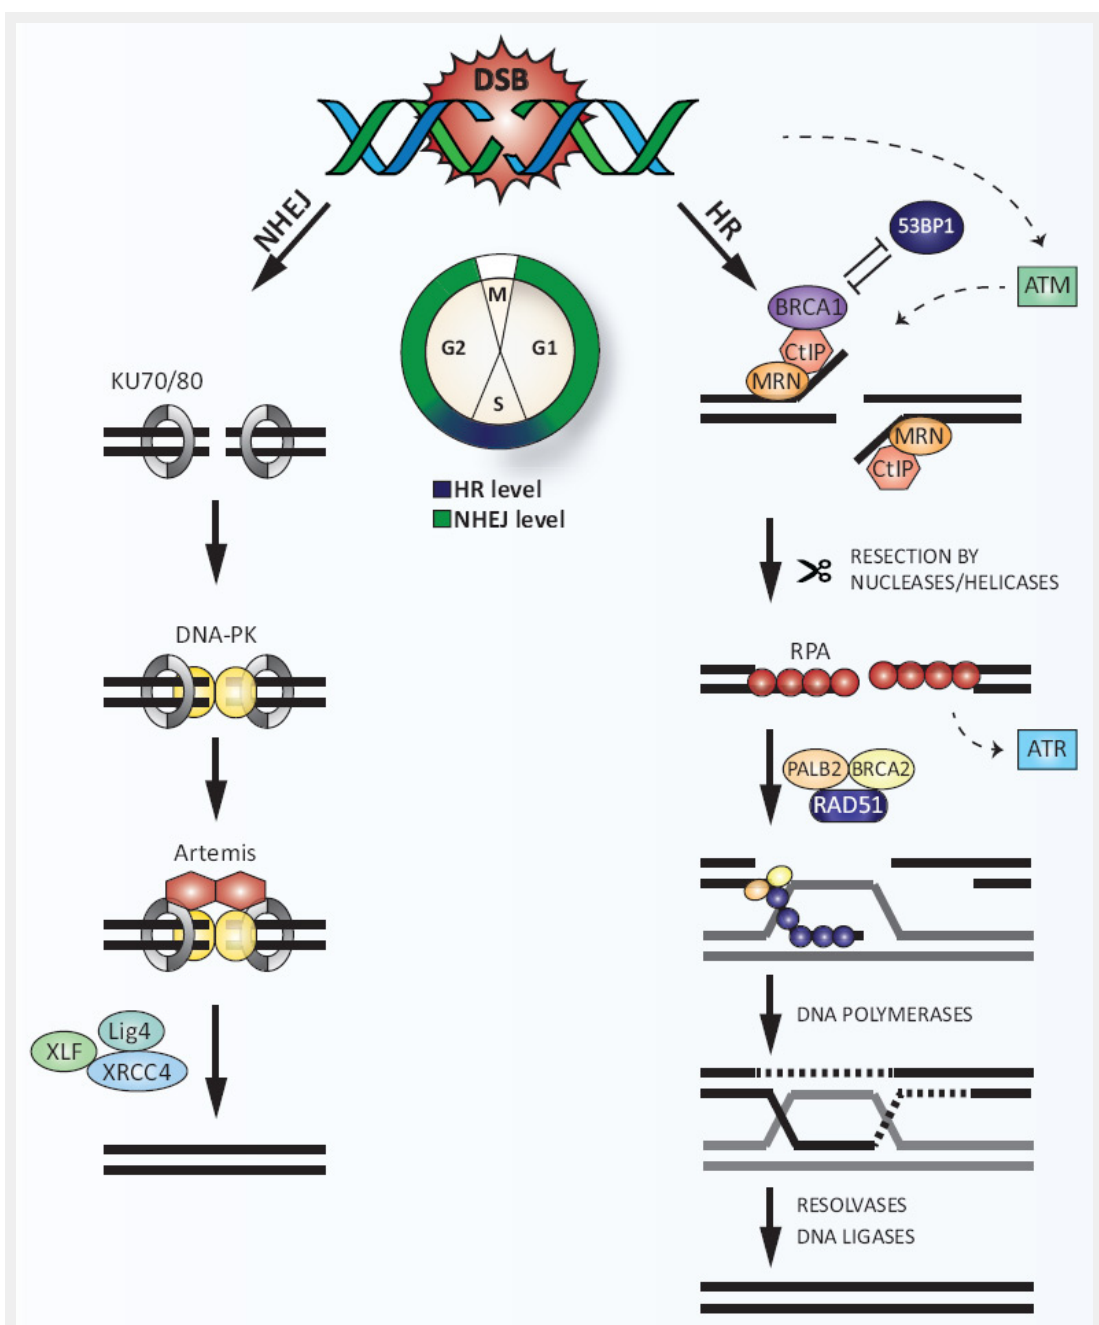
DNA double-strand break (DSB) repair. DSBs are predominantly repaired by two distinct pathways: NHEJ or HR. NHEJ operates throughout the cell cycle, but mainly during the G1 and G2 phases, whereas HR peaks in S phase. Rapid association of the Ku70/80 heterodimer to DSBs promotes NHEJ by recruiting DNA-PKcs. DNA ends are processed by the nucleolytic activity of Artemis, followed by religation catalysed by a complex of XLF, Ligase IV (Lig4) and XRCC4. Alternatively, MRN, which is initially recruited to DSBs in competition with Ku70/80, initiates DSB resection together with CtIP thereby promoting HR. 53BP1 antagonises BRCA1 in DSB resection. Extensive DSB resection by other nucleases and formation of RPA-coated ssDNA stimulates the activation of ATR. Displacement of RPA by RAD51 is mediated by BRCA2 and PALB2, resulting in the formation of RAD51 nucleoprotein filaments. Subsequent strand invasion into the homologous DNA template and capturing of the second DNA end leads to the formation of a double Holliday junction, which is processed by resolvases. Finally, the DNA is sealed by ligases to accomplish error-free repair of the DSB. 53BP = p53 binding protein; ATM = ataxia telangiectasia mutated protein; CtBP = C-terminal binding protein; CtIP = CtBP-interacting protein; DNA = deoxyribonucleic acid; DNA-PK = DNA-dependant protein kinase; DNA-PKcs = DNA-PK catalytic subunit; HR = homologous recombination; MRN = MRE11-RAD50-NBS1 complex; NEHJ = nonhomologous end joining; PALB1/2 = partner and localiser of BRCA1/2; RPA = replication protein A; ssDNA = single-stranded DNA; XLF = XRCC4-like factor; XRCC4 = X-ray repair cross-complementing protein